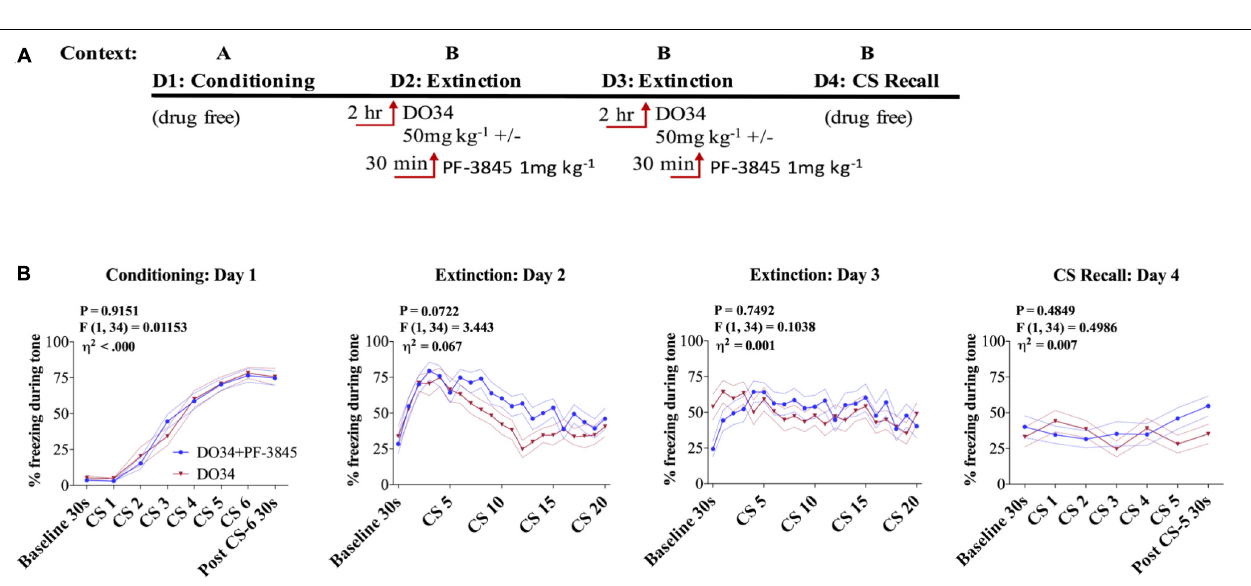
FIGURE 4 | Pharmacological DAGL inhibition does not affect unconditioned freezing. (A) Schematic diagram of the experimental paradigm. (B) (Far left panel) % freezing by C57BL/6J male mice during sham-conditioning assay-no shock was administered after tone. (Middle panels) % freezing during auditory cue during extinction training days 2 and 3. (Far right panel) % freezing during extinction recall ( n = 15 male mice per condition). F - and P -values and η 2 for main effect of drug treatment shown in each panel. All values are presented as mean ± SEM.